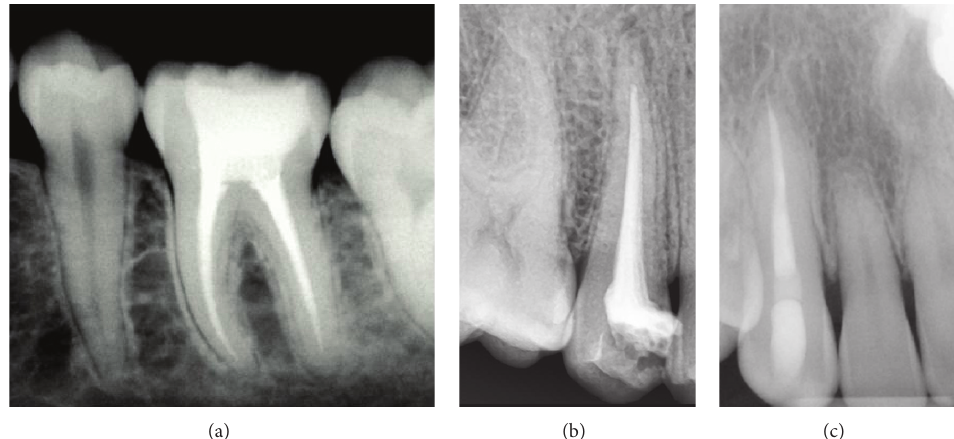
Figure 5: Radiographs depicting adequate quality root canal (a), inadequate/short length (b), and inadequate/overextended length